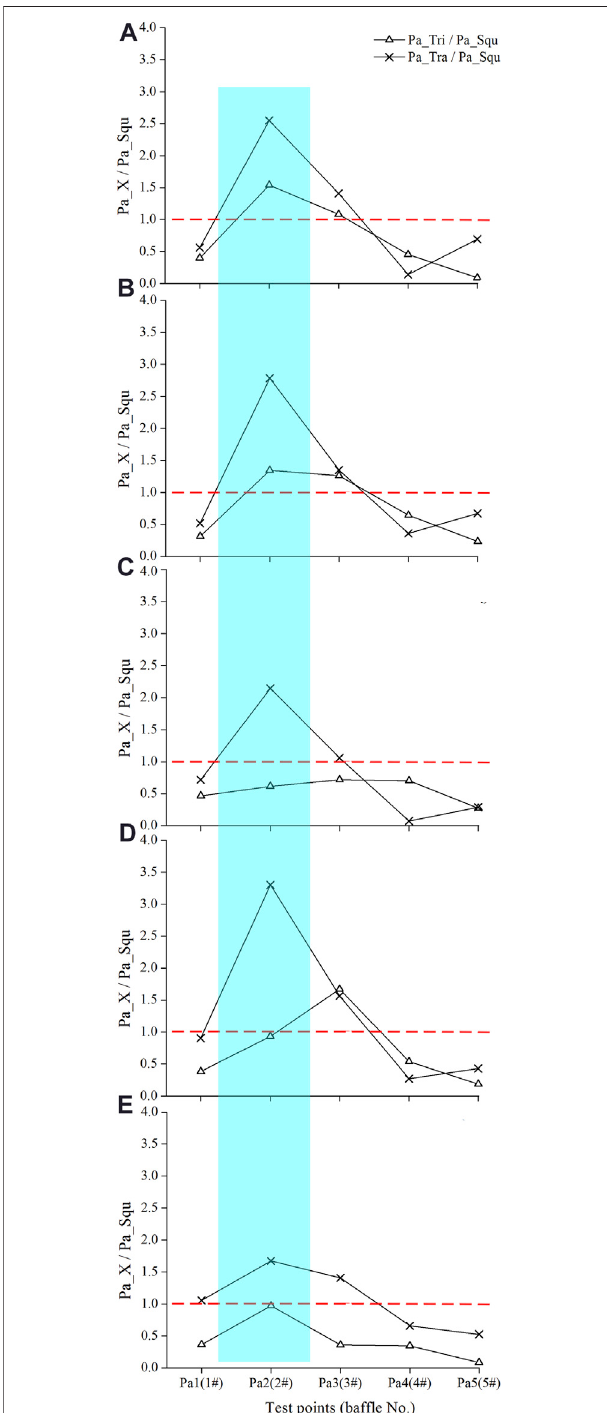
FIGURE 9 | Variation of the peak pressure attenuation on baf fl es along thechannel for (A) C s = 0.48; (B) C s = 0.51; (C) C s = 0.55; (D) C s = 0.59; (E) C s = 0.65. The red dashed line means the impact force on the triangle or trapezoid baf fl es is equal to that on the square baf fl es.